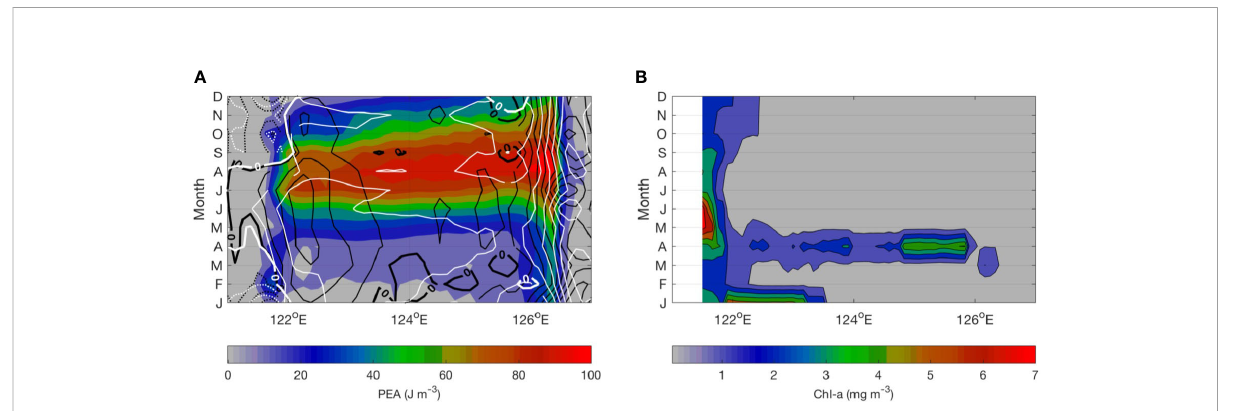
FIGURE 10 (A) Monthly variability of potential energy anomaly (PEA) with integration limited from surface to 200 m along the 28°N section based on model output in 2011. The PEA is zero for a fully mixed water column, positive for stable strati fi cation, and negative for unstable strati fi cation. The black contour lines indicate the depth - averaged north – south currents, with northward denoting positive values (black solid lines) and southward denoting negative values (black dashed lines). The white contour lines indicate the east – west currents, with eastward denoting positive values (white solid lines) and westward denoting negative values (white dashed lines). (B) Monthly variability of MODISA Chl -a along the 28°N section in